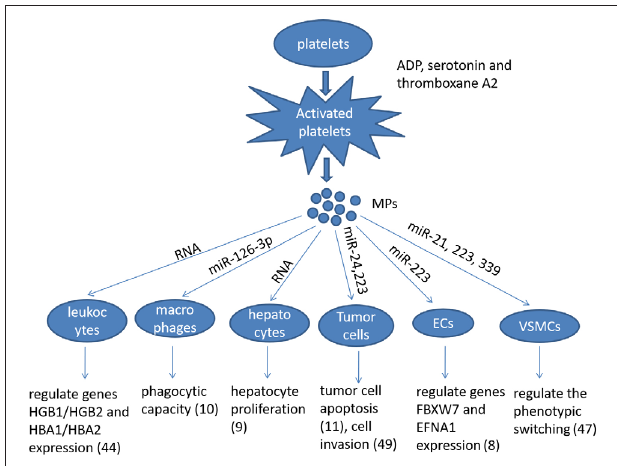
figuRe 1 | Summarizing the role of platelet microparticles (MPs) in cellular activation by the transfer of miRNAs. Ecs: endotheilal cells, VSMCs: vascular smooth muscle